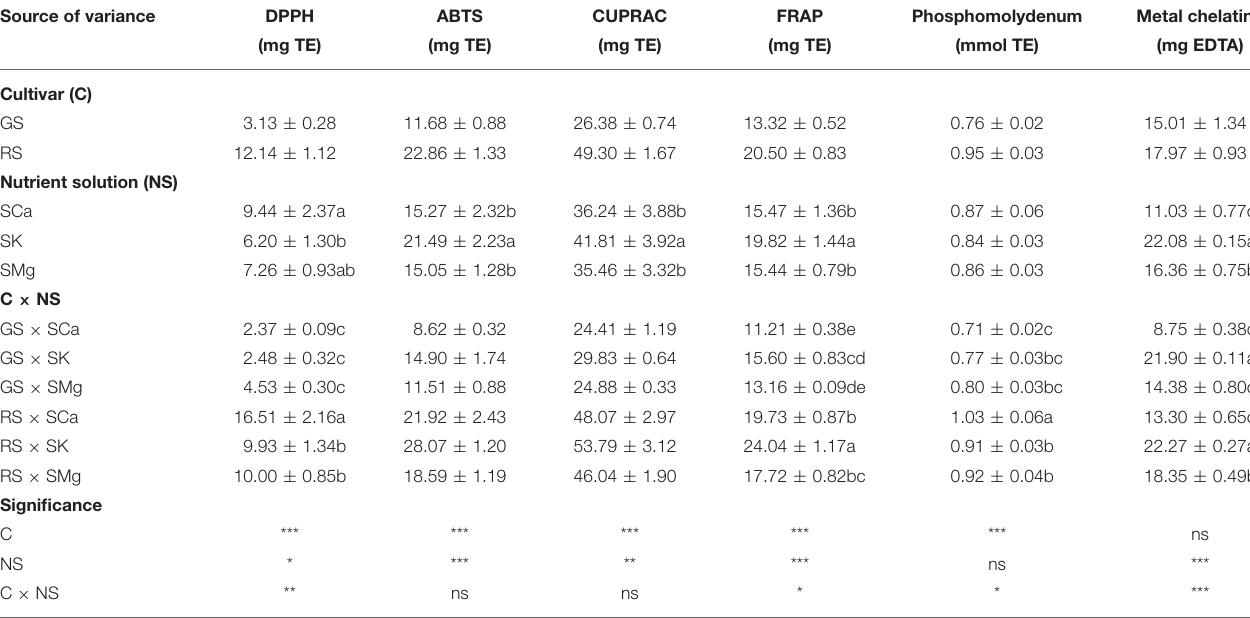
TABLE 6 | Effects of the C and of the NS of antioxidant capacity of the leaves. Source of